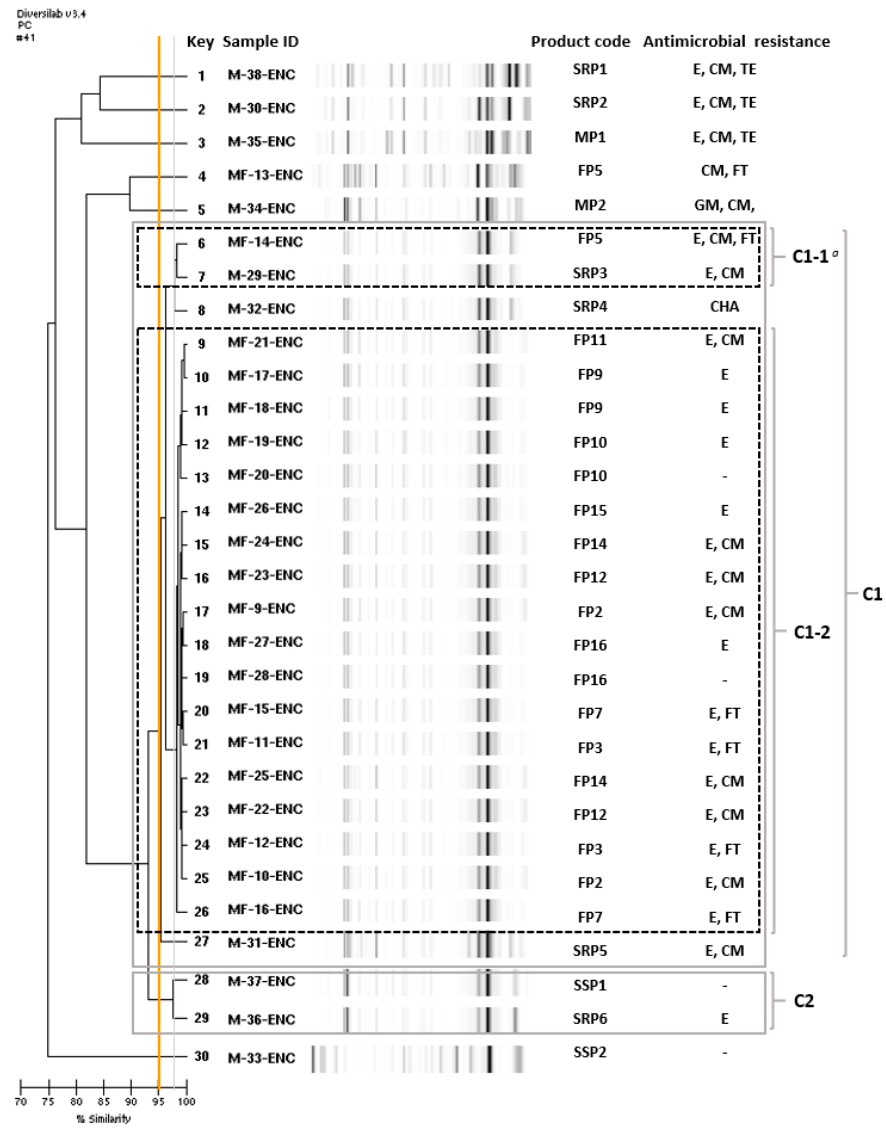
Figure 2. Molecular typing of Enterococcus faecium isolates obtained from the commercial processed pork meat products in Korea. The dendrogram shows the molecular typing results obtained by rep-PCR with the Diversilab method. The total number of isolates analyzed in this study was 30. Clusters with Diversilab similarity ≥ 95% are marked with a grey rectangle and numbered (C1 and C2). Clusters with a similarity ≥ 98% are marked with a black dotted line and numbered C1-1 and C1-2. The abbreviation in the product code represents MP (minced pork meat), SRP (ready-to-cook pork meat products seasoned with red pepper paste), SSP (ready-to-cook pork meat products seasoned with soy sauce) and FP (frozen meatball-type processed pork meat products). Antimicrobial resistances were observed for Erythromycin (E), Clindamycin (CM), Tetracycline (TE), Nitrofurantoin (FT), Chloramphenicol (CHA) and Gentamicin (GM). a Cluster number.